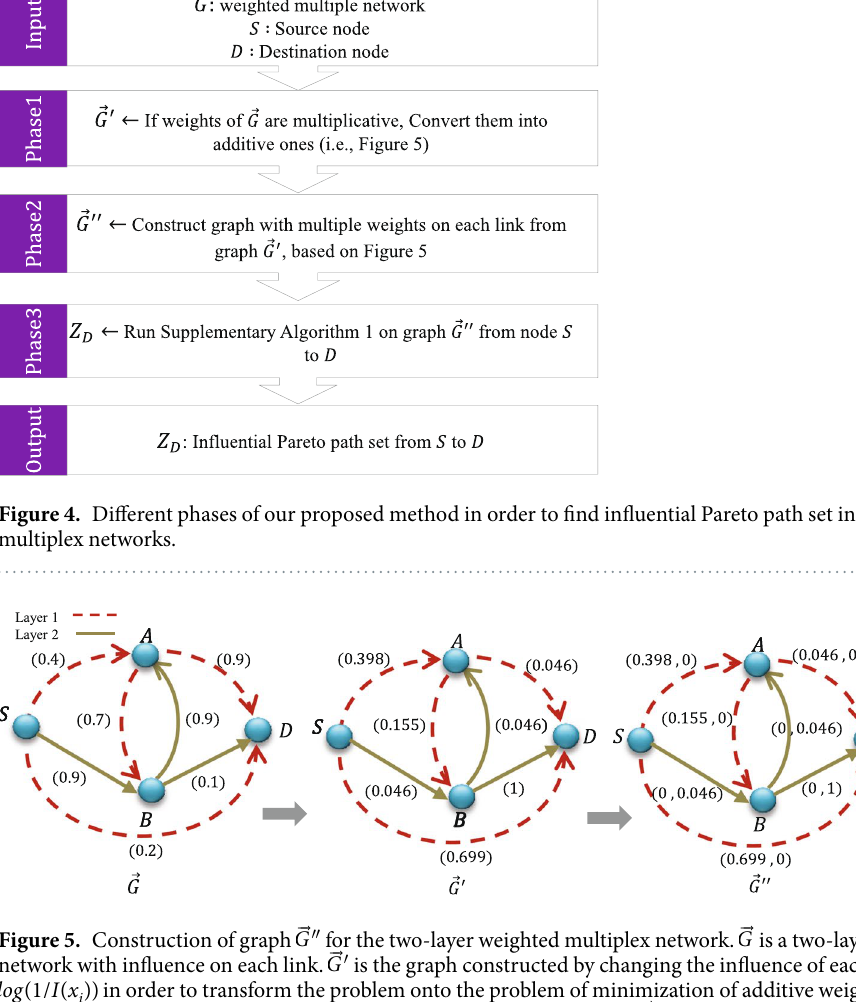
Figure 5. Construction of graph ″ network with influence on each link. ′ log I x (1/ ( )) i in order to transform the problem onto the problem of minimization of additive weights. ″ multiplex network with multiple weights on each link constructed from ′